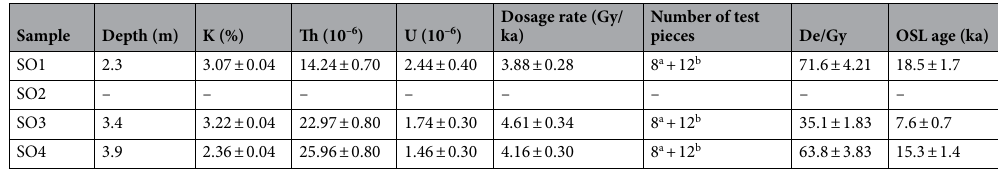
(Table 1). Four samples were also collected for OSL dating at the OSL laboratory of the Institute of Mountain Hazards and Environment, Chinese Academy of Sciences (IMHE, CAS). The OSL dating results are shown in Table 2. Additionally, OSL dating of samples from each of the lower three units was performed on a Lexsyg Research automatic TL/OSL instrument at the IMHE, CAS. The sample from the silt unit gave an OSL age of 7.6 ± 0.7 ka, which is consistent with the radiocarbon age. The other two samples gave ages of 18.5 ± 1.7 ka (fine sand) and 15.3 ± 1.4 ka (coarse sand) (Fig. 2D); the difference may be due to their larger grain size, or lack of bleaching in a catastrophic flood event 20 . Combining the OSL and radiocarbon dating results gives a probable age of ~ 7 ka BP for the Shuangyu SWD. In addition, we found lacustrine deposits (N 30° 09 ′ 05 ″ , E 94° 59 ′ 42 ″ ) at the mouth of Dayi Creek, a Yigong tributary, 2 km upstream of the Shuangyu SWDs (Fig. 1C). The 2.2 m parallel lacustrine lamination with yel- low–brown silt is elevated ca. 40.0 m above the adjacent floodplain. It is capped by a 4.3 m debris-flow accumu- lation composed of angular and sub-angular gravels and boulders. A 1.5 m no-bedding mixture with sand and gravels is exposed underneath the lacustrine lamination (Fig. 3A). Two pieces of charcoal were taken from the silt deposit and radiocarbon dating was performed at the Beta Analytic laboratory, USA (Fig. 3B). The 14 C ages are determined to be 6.3 ka BP and 6.6 ka BP, which means that the Dayi lacustrine deposits are a few centuries younger than the Shuangyu SWD. The sedimentary sequence is located at the mouth of the Dayi Creek branch on the right bank of the Yigong River. The bank is a concave bend behind a narrow reach. The transport capac- ity of the 7 ka BP superflood decreased and a large volume of sediment carried by the superflood stopped here. We speculate that the paleoflood deposits jammed the outlet of the Dayi, forming a small temporary dammed lake in the creek. Inflow silt was deposited in the dammed lake and produced lacustrine deposits. The upper debris-flow accumulation on the lacustrine deposits implies that large-scale debris flows probably occurred in Dayi and breached the temporary dam. The modern flood SWDs.